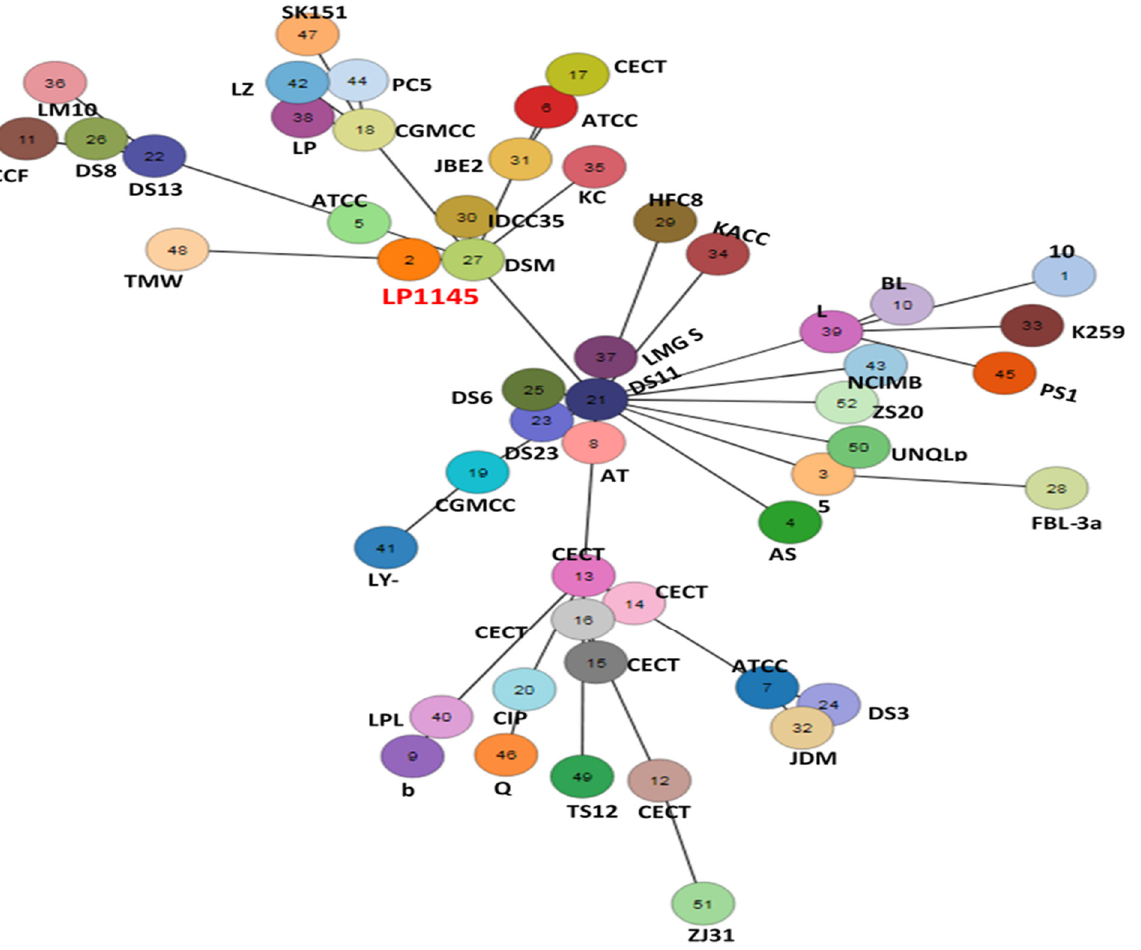
Figure 7. The allele-based minimum spanning tree constructed with cgMLST profiles for the 52 Lactiplantibacillus plantarum subsp. plantarum strains on the basis of a comparison of 2233 core genes. Each circle represents a different sequence type.